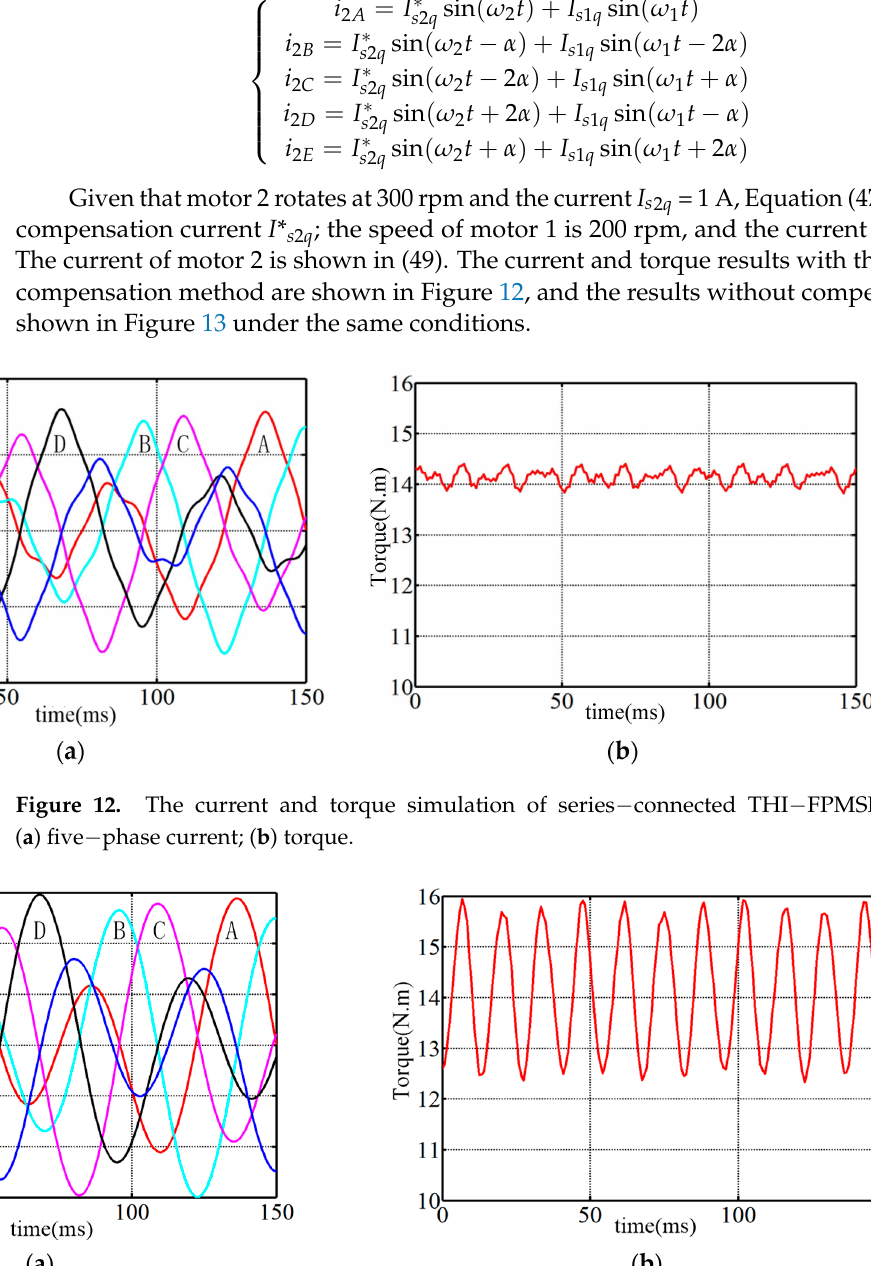
Figure 13. The current and torque simulation of series − connected THI − FPMSM without i cmp : ( a ) five − phase current; ( b ) torque.